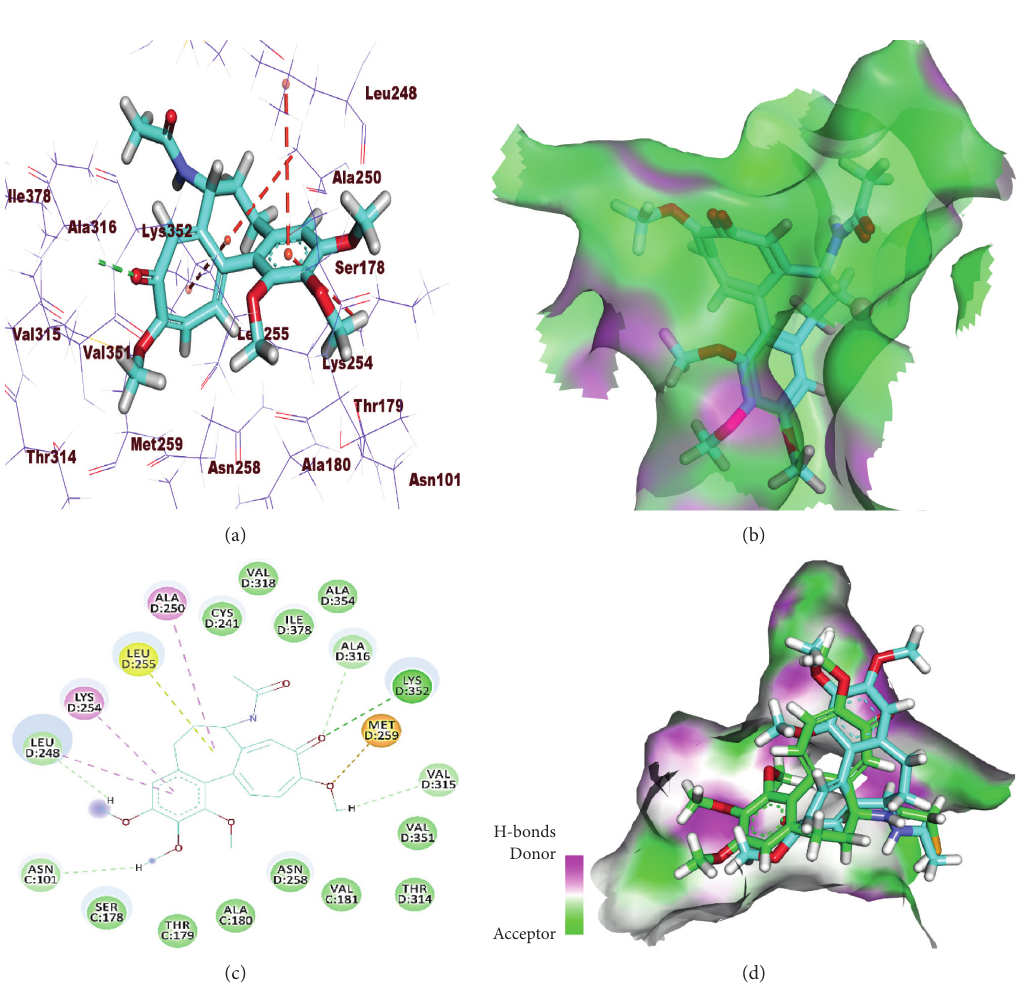
Figure 7: (a) 3D structure of colchicine, docked into the colchicine binding site. (b) Mapping surface showing colchicine, occupying the active pocket of colchicine binding site. (c) 2D structure of colchicine, docked into the colchicine binding site. (d) 3D alignment of colchicine (carbon atoms in turquoise) with the DAMA-colchicine (carbon atoms in